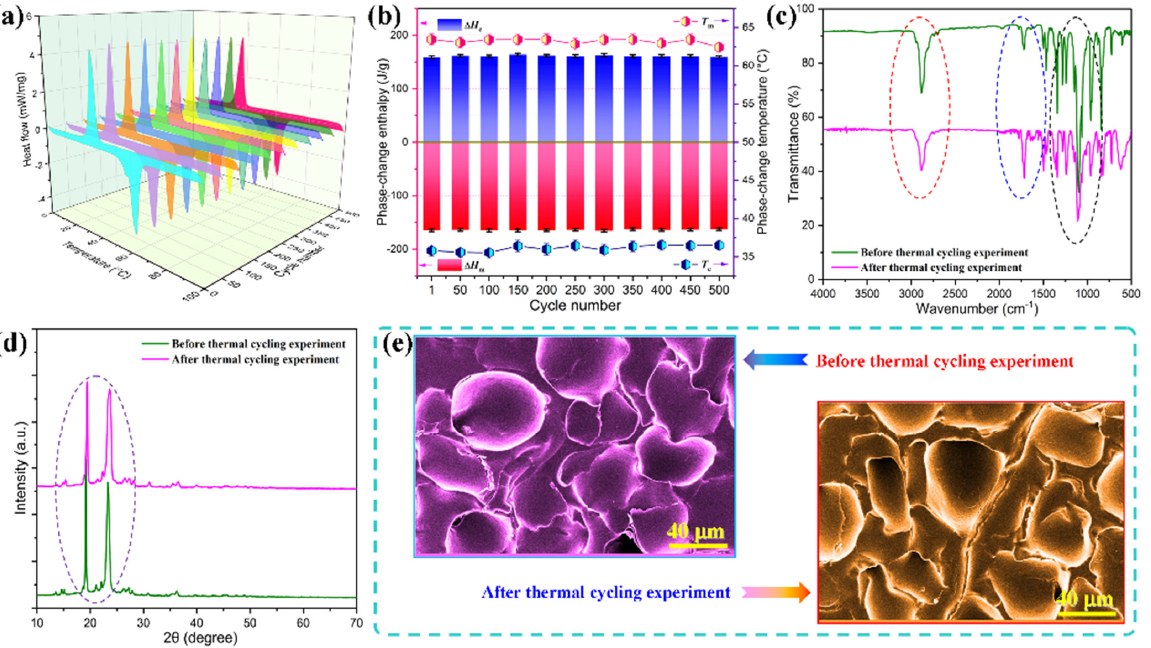
Figure 12. ( a ) Multicycle DSC thermograms and ( b ) phase-change temperatures and enthalpies of the PI/graphene/Fe 3 O 4 aerogel/PEG composite film containing 5 wt% graphene nanosheets and 6 wt% Fe 3 O 4 nanoparticles obtained from the thermal cycling experiment at every 50 thermal cycles. ( c ) FTIR spectra, ( d ) XRD patterns, and ( e ) SEM micrographs of the aerogel/PEG composite film before and after the thermal cycling experiment.